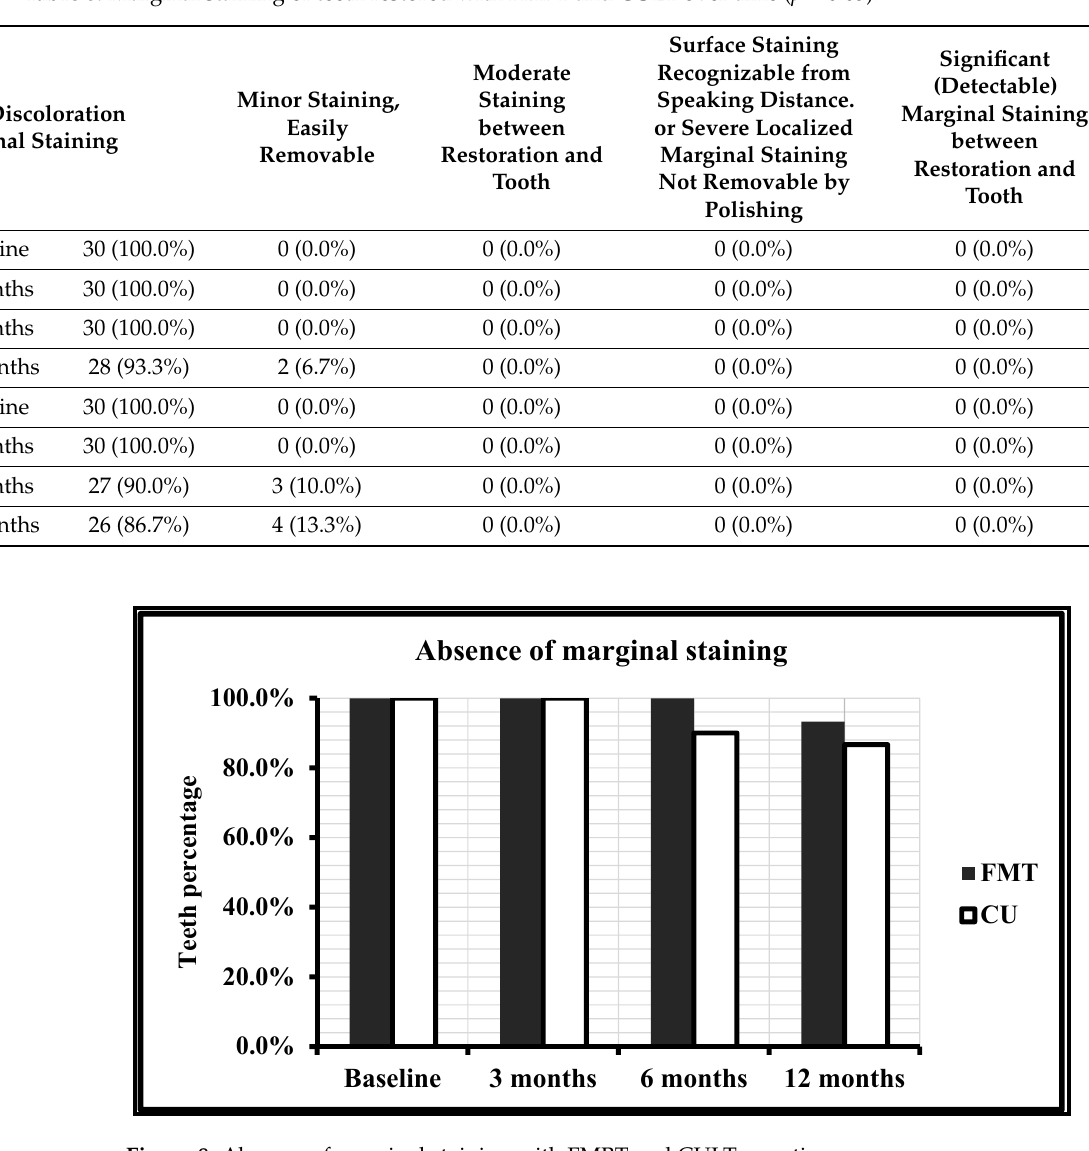
Table 8. Marginal staining of teeth restored with FMBT and CULT over time ( p < 0.05).